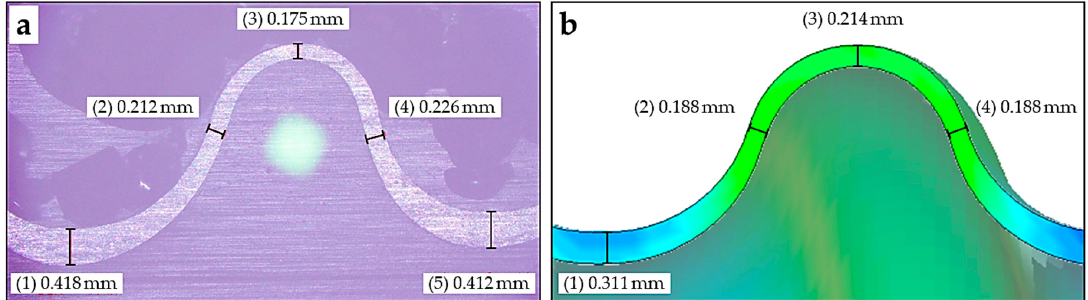
Figure 9. Comparison between actual wall thinning ( a ) and simulated wall thinning ( b ) in the longitudinal section.